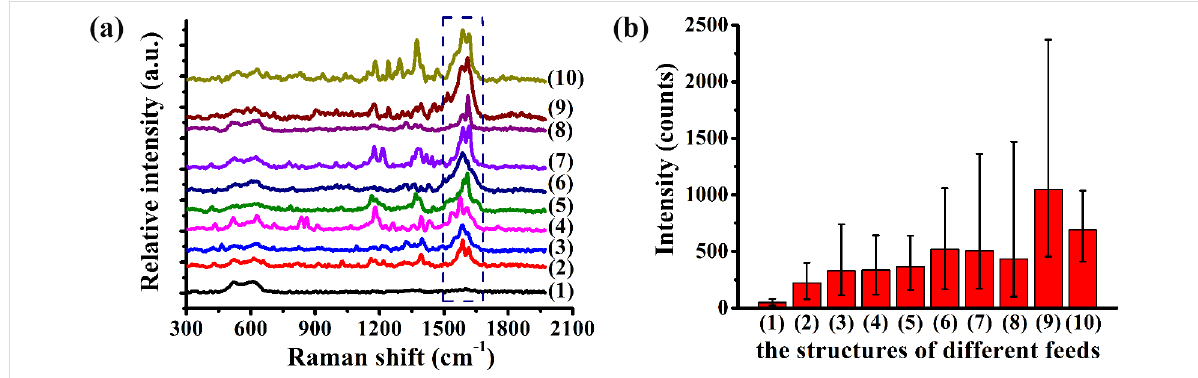
Figure 11: (a) Raman spectra of MG molecules at 10 − 7 mol/L on hierarchical SERS Ag/Cu substrates with a corrosion time of 10 minutes with the dif- ferent feeds. (b) The average Raman intensity of the 1614 cm − 1 peak of MG molecules in the Ag/Cu structures as a function of different feeds. The feed structures (1)–(10) are described in Table